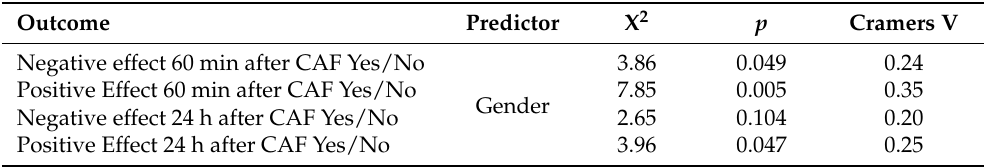
Table 1. Association between GENDER predictor and NEGATIVE/POSITIVE effects after CAF